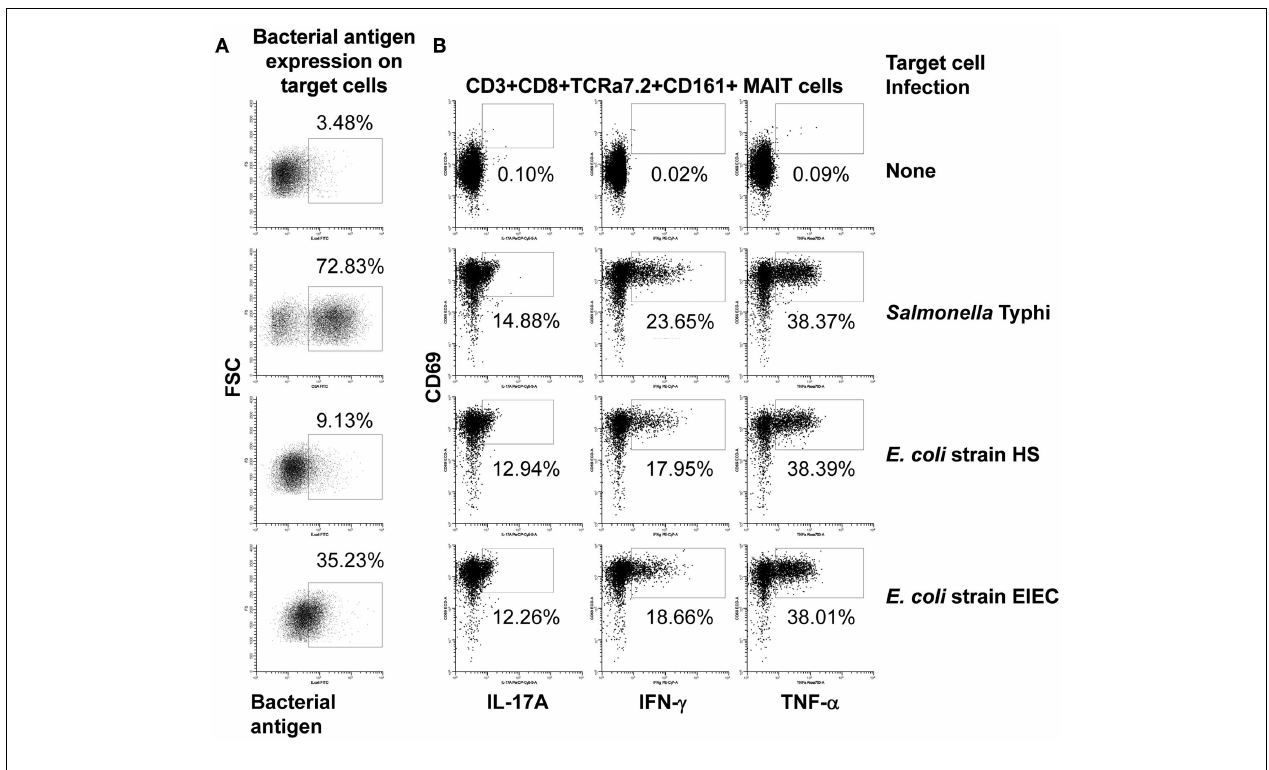
were stained with antibodies to E. coli or CSA, respectively. (B) Percentage of cytokine-secreting MAIT cells after 16–18h of co-culture with uninfected or infected-B-LCL targets. Cytokine production by MAIT cells was evaluated by flow cytometry. Data are representative of five